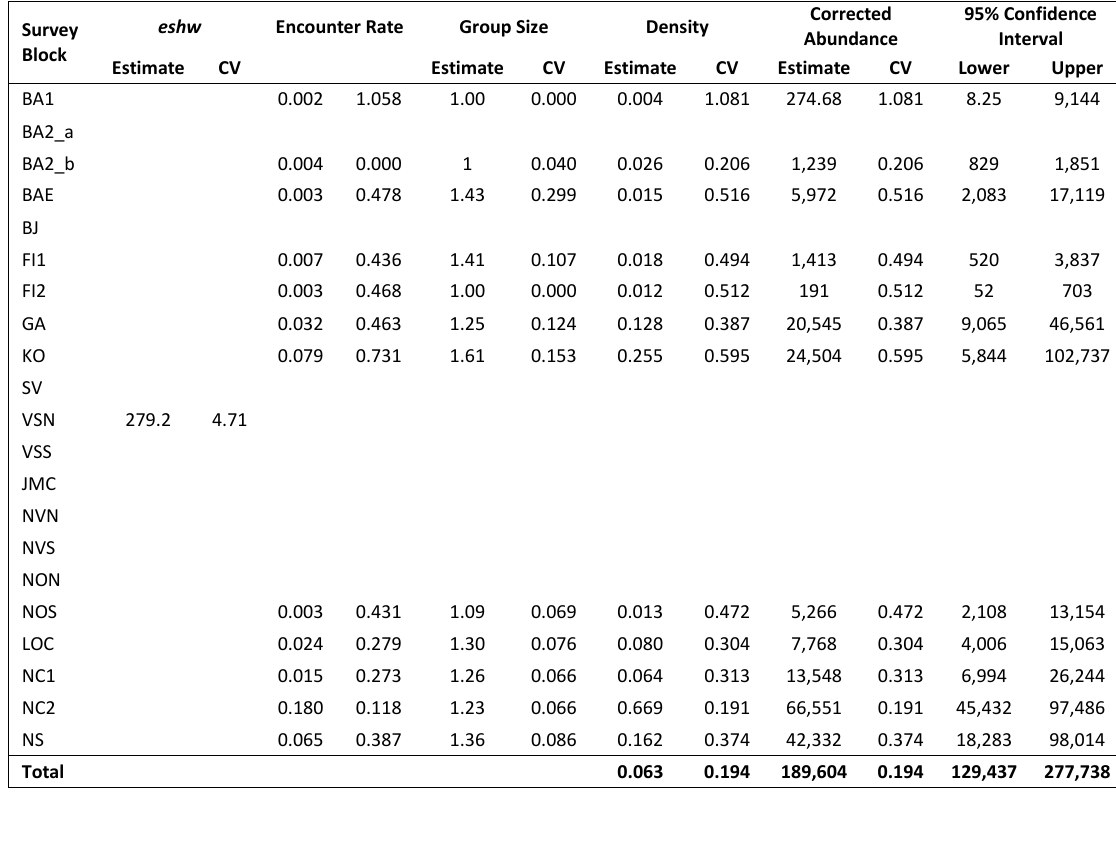
Table 10. Estimated density and abundance of harbour porpoises from the 2002 – 2007 survey (a) and the 2008 – 2013 survey (b). The eshw (effective search half width (m)) was estimated for the entire study region. Encounter rate, group size, density, abundance, and upper and lower confidence limits were estimated by block and corrected for perception bias, with the estimated p